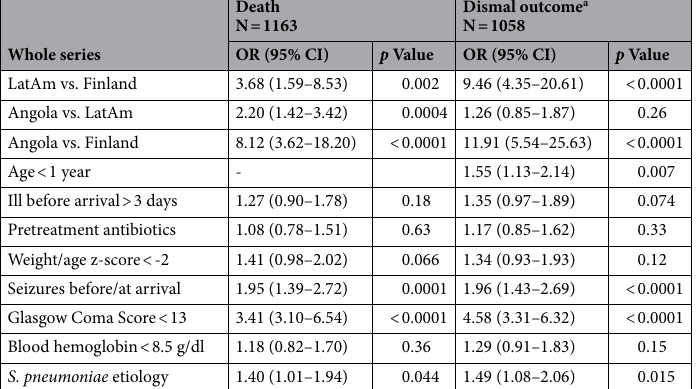
Table 3. Odds ratios with 95% confidence intervals of variables related to death or dismal outcome, multivariate analysis. a Death or severe neurological sequelae or